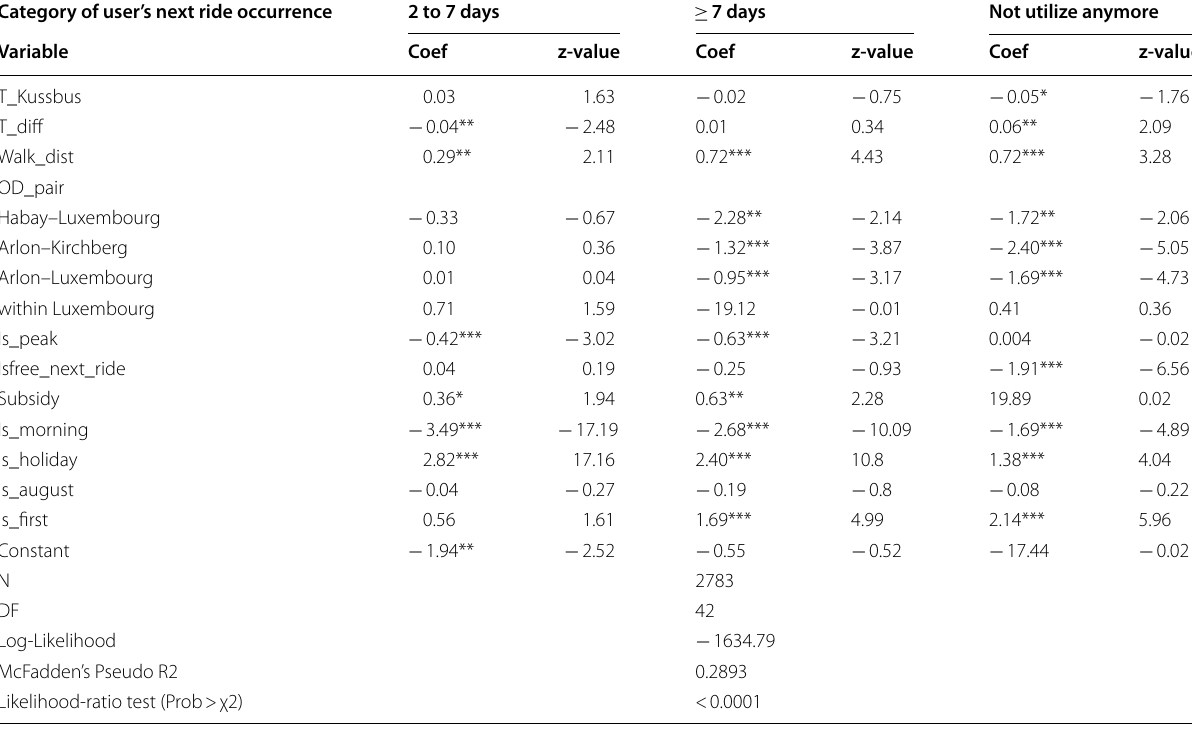
Table 6 Multinomial logit model